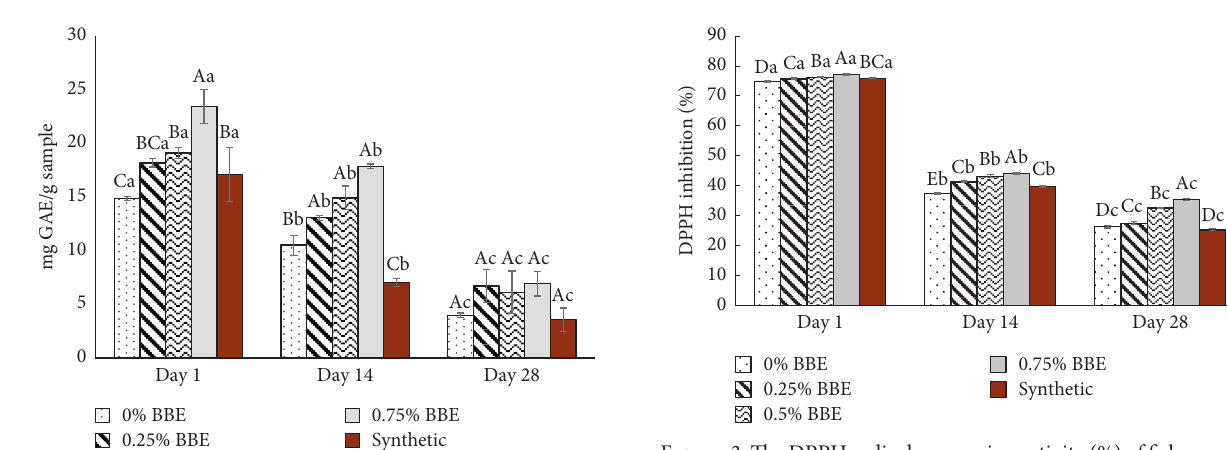
Figure 3: The DPPH radical scavenging activity (%) of fish sausages samples fortified with 0%, 0.25%, and 0.5% BBE and synthetic additives. Values of means ± standard deviation (SD) of triplicate independent experiments. Different capital letters indicate signif- icant differences ( p < 0 . 05) within the samples in the same day. Different small letters indicate significant differences ( p < 0 . 05) of the same sample across the storage days 1, 14, and 28 at 4 ° C.